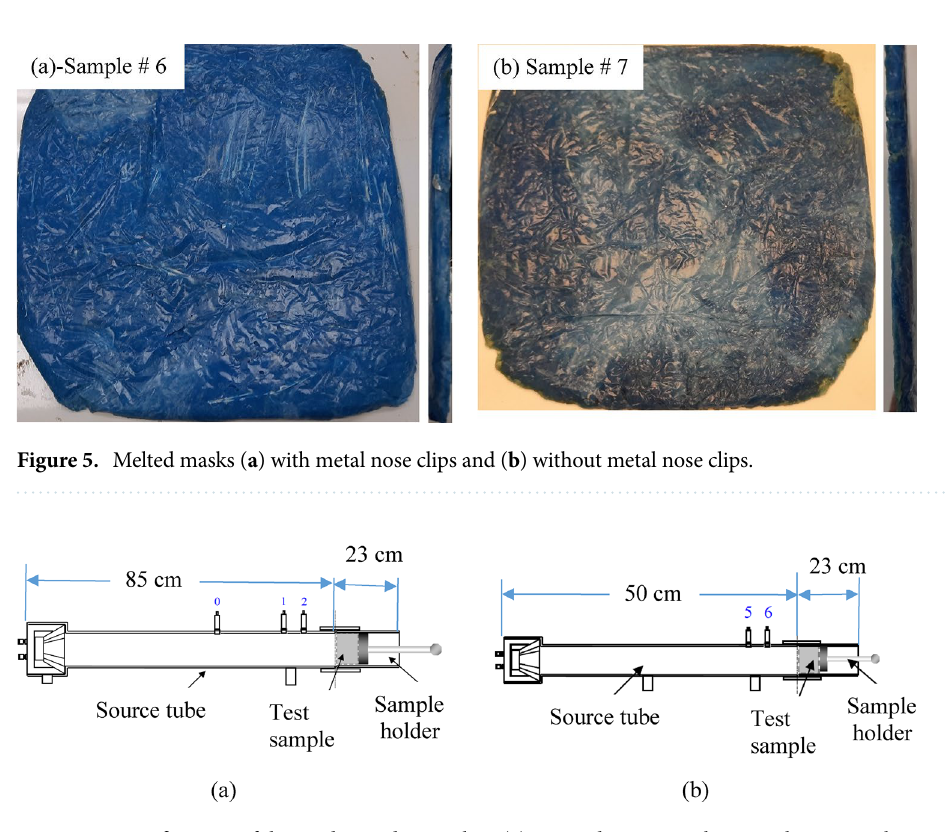
Figure 6. Specifications of the used impedance tubes; ( a ) 10 cm diameter with microphones number 0, 1, and 2 and ( b ) 3 cm diameter with microphone number 5 and